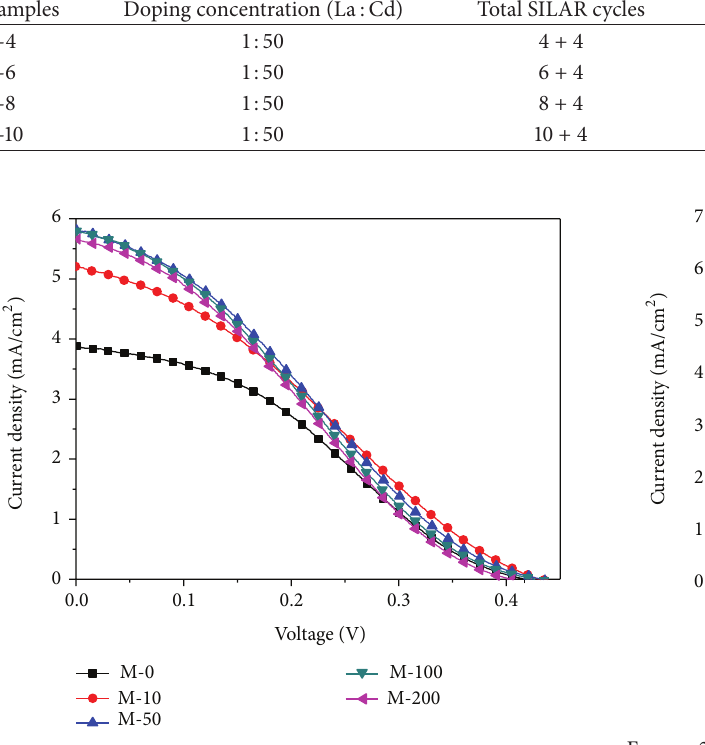
Figure 1: The 𝐽 - 𝑉 curves of different working electrodes based on La-doped CdS. The corresponding parameters are of M-0, M-10, M- 50, M-100, and M-200.